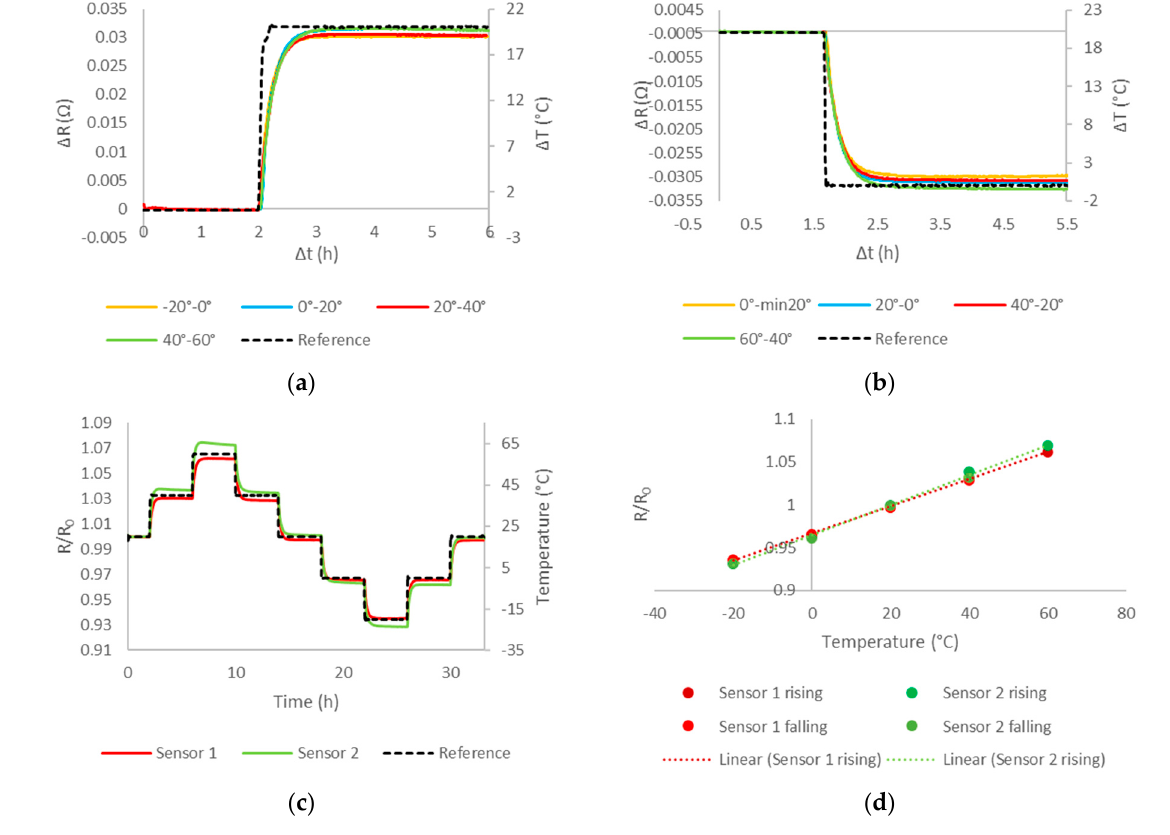
Figure 8. Response of sensor 1 to the step function: ( a ) rising temperature; ( b ) falling temperature; ( c ) sensor responses to temperature step response function ranging from − 20 to 60 °C with a step-size of 20 °C; ( d ) temperature response at steady state (5 τ ).